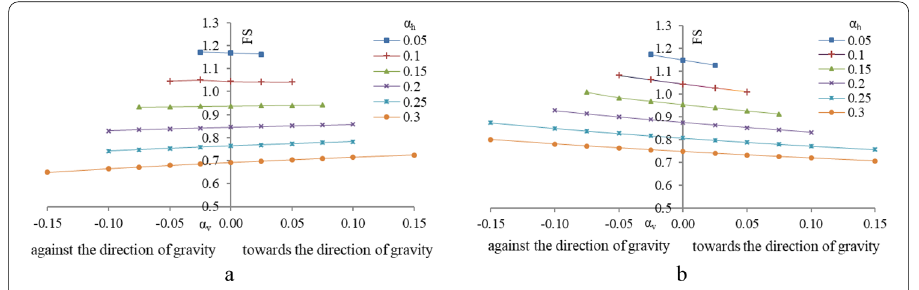
Fig. 3 FS vs α v on different values of α h : a case 1and b case